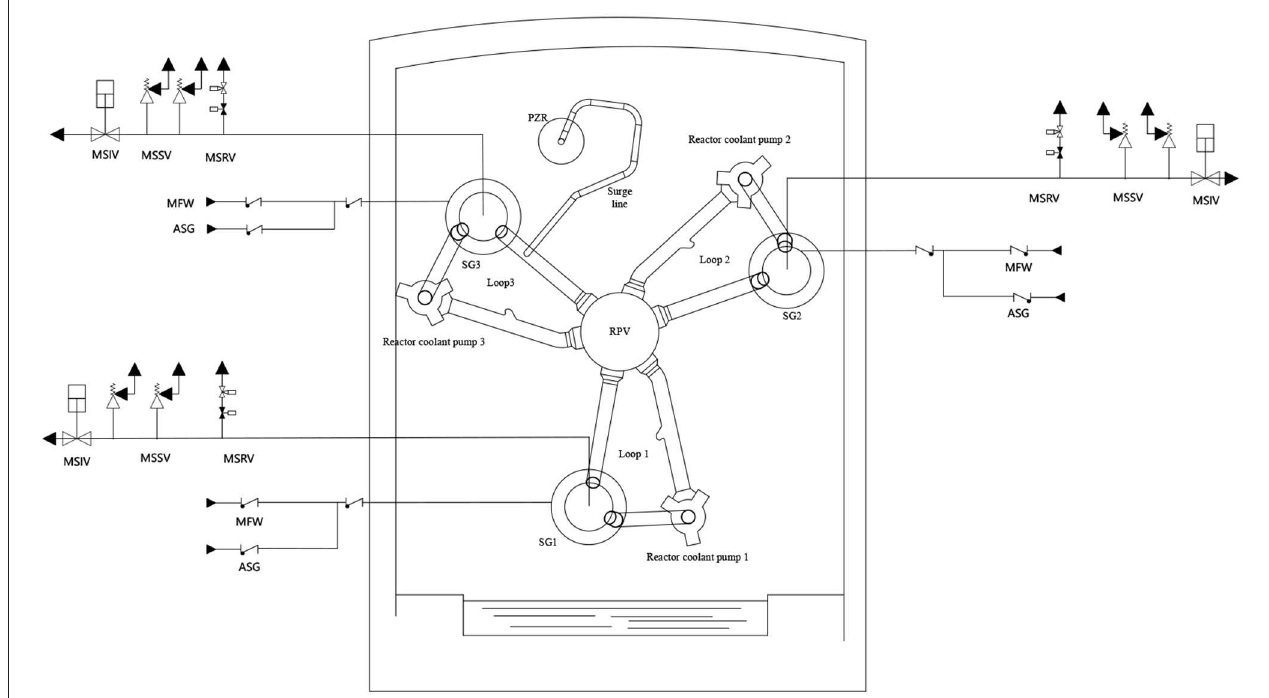
FIGURE 1 | System layout of nuclear